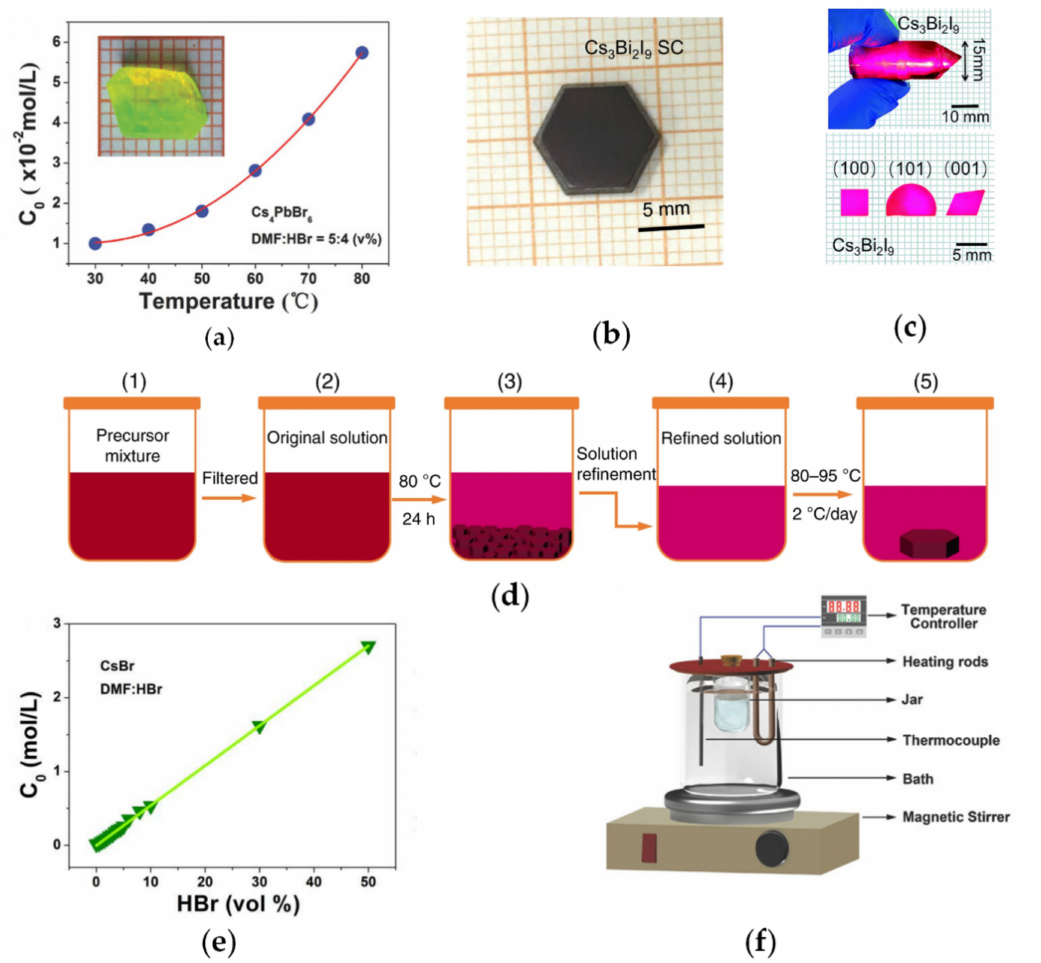
Figure 4. ( a ) Photograph of a grown embedded crystal and the Cs 4 PbBr 6 solubility curve. Adapted with permission from Ref. [91]. 2018, John Wiley and Sons; ( b ) optical image of Cs 3 Bi 2 I 9 PSC grown by a nuclei-control method. Adapted with permission from Ref. [90]. 2020, Springer Nature; ( c ) photographs of Cs 3 Bi 2 I 9 PSCs grown by the Bridgman method Adapted with permission